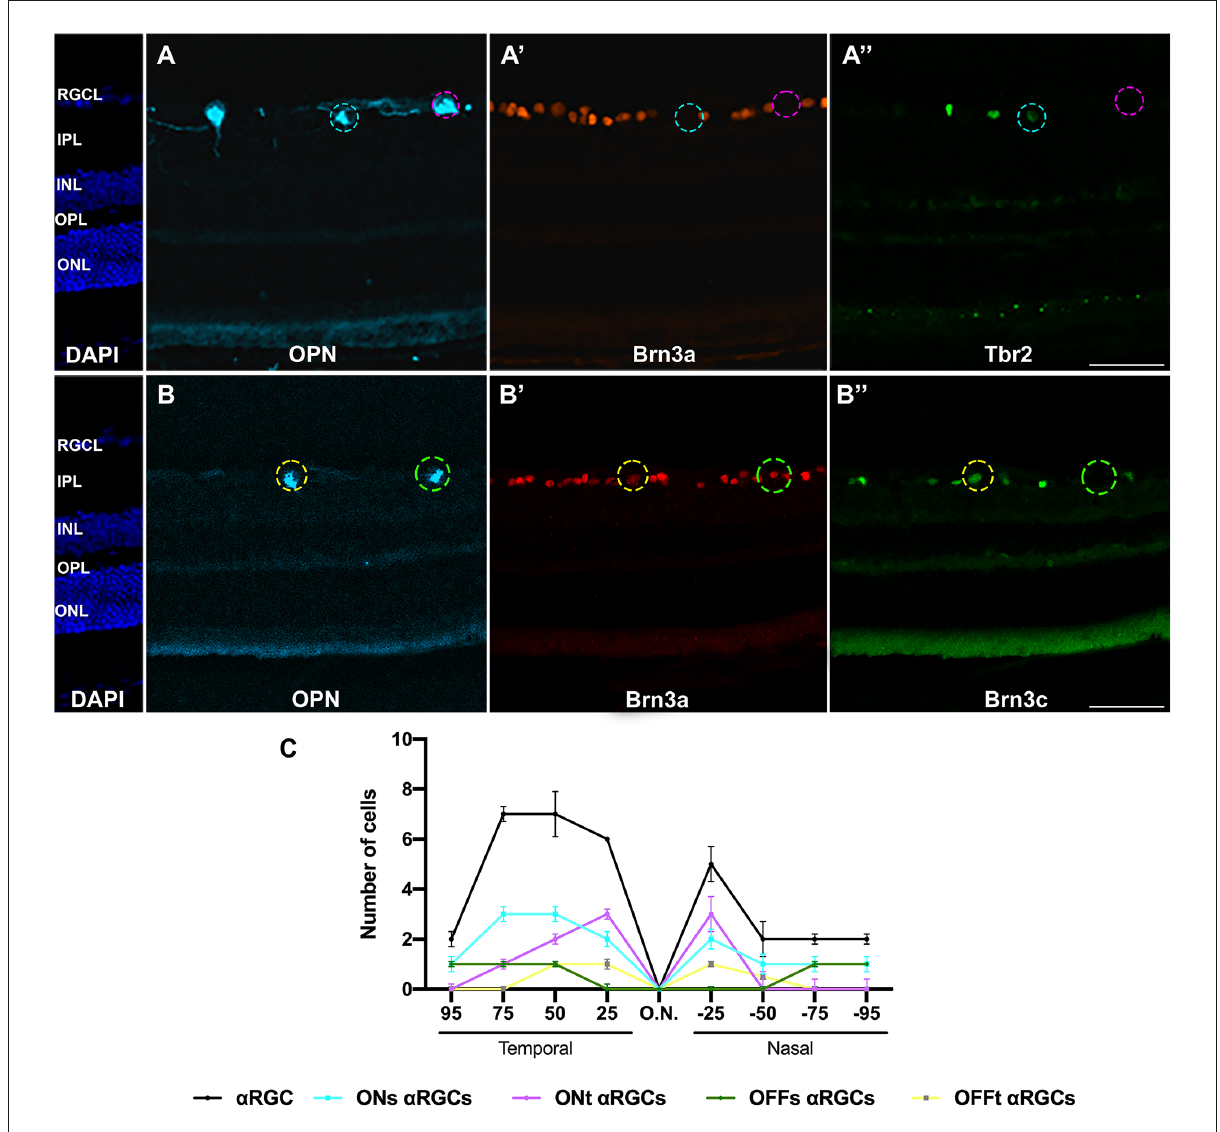
FIGURE8 Immunohistochemical identification of α RGCs types in radial retinal sections. Magnifications of retinal sections immunodetected against OPN, Brn3a, and Tbr2 (A–A”) to identify ONs- α RGCs (OPN + Brn3a − Tbr2 + , blue traced circle) and ONt- α RGCs (OPN + Brn3a − Tbr2 − , pink traced circle) and against OPN, Brn3a, and Brn3c (B–B”) to identify OFFs- α RGCs (OPN + Brn3a + Brn3c − , green traced circle) and OFFt- α RGCs (OPN + Brn3a + Brn3c + , yellow traced circle). (C) Graph illustrating manual counting of α RGCs and its subtypes in different retinal regions,